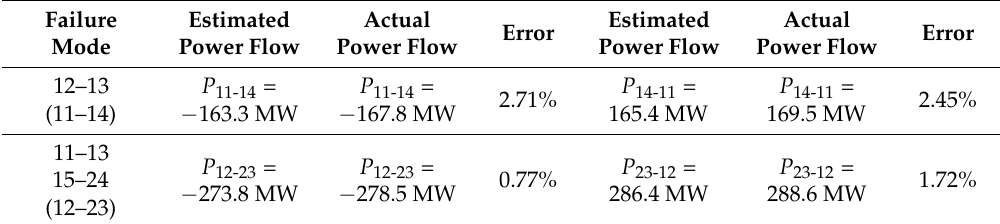
Table 5. The calculation results of two cases to further valid SE.